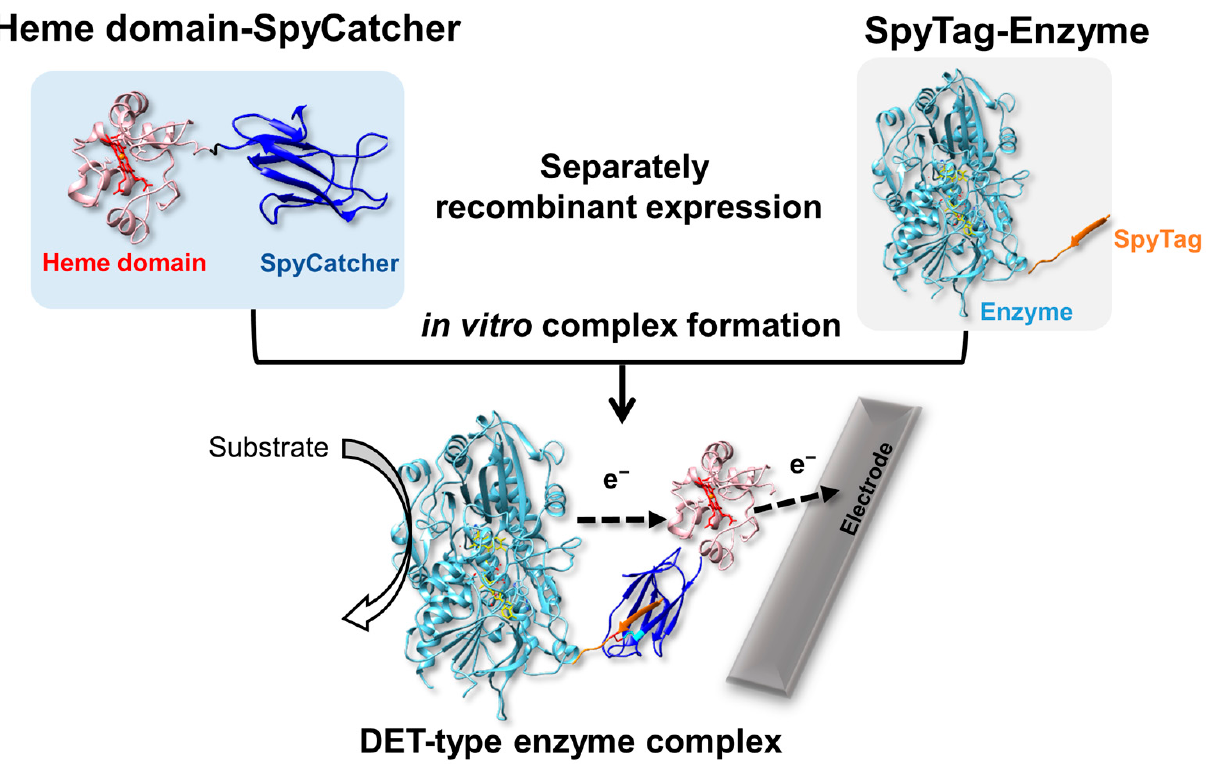
Table 1. Information about flavin-dependent oxidoreductases demonstrated in this